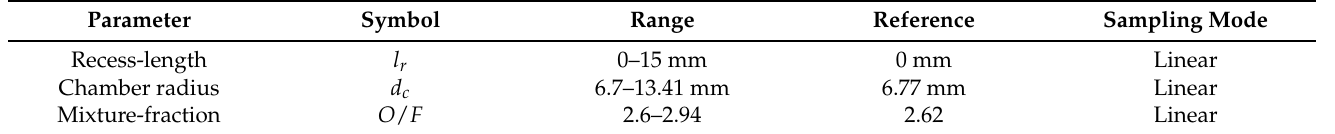
Table 1. Parameter range, reference values, and sampling mode for the three parameters of the design of